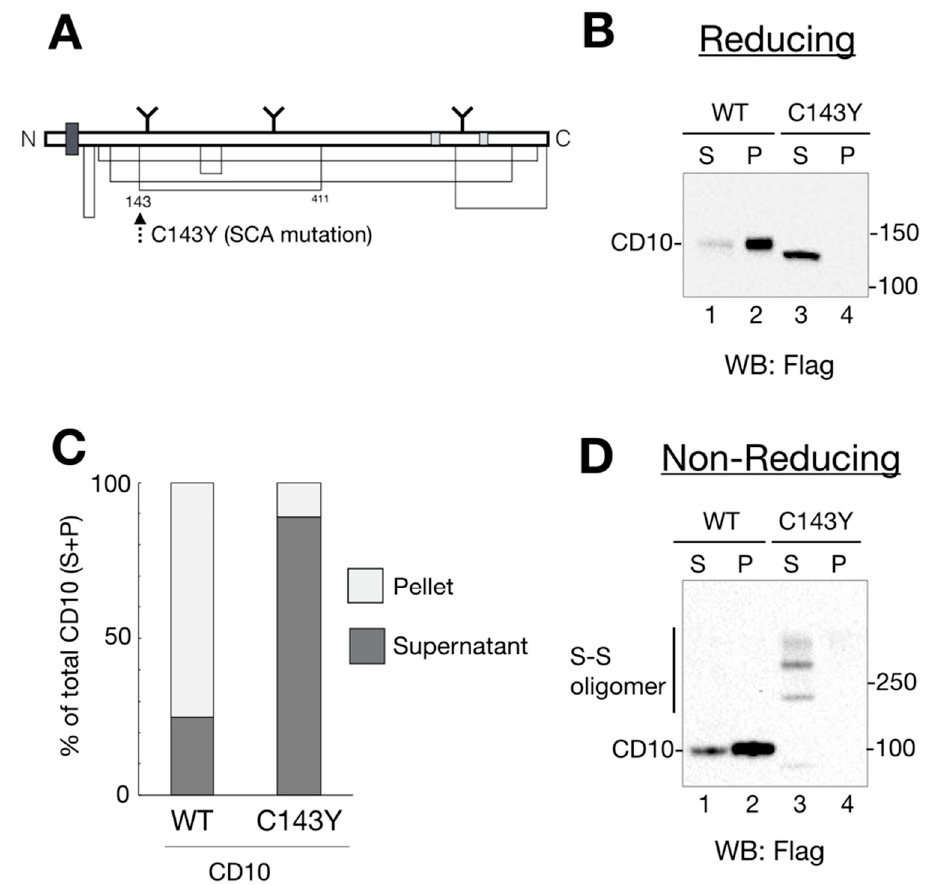
Figure 1. Spinocerebellar ataxia (SCA)-derived CD10 cysteine mutation causes aberrant disulfide bond formation and insufficient raft localization. ( A ), schematic representation of human CD10 structure. The thick dark gray square shows the transmembrane domain. N-linked glycans are noted as Y motifs with the glycosylation position. Enzyme catalytic sites are depicted in light gray. Disulfide bonds are shown as a solid line. Location of a SCA-related C143Y mutation is denoted by a dotted arrow. ( B ), wildtype (WT) CD10 is detected in a Triton X-100-insoluble fraction, whereas C143Y is solubilized. HeLa cells transfected with WT CD10 or C143Y-Flag vector were lysed and fractionated into detergent-soluble (S; soluble) and -insoluble (P; pellet) fractions. Proteins were resolved in reducing SDS-PAGE, followed by immunoblotting using anti-Flag antibody. Molecular weight of the marker proteins is shown on the right side of the gel. Lane numbers are shown on the lower side of the gel. ( C ), Quantification of B (ratio of S and P) is shown. The percentage of each band (WT, lanes 1 and 2; C143Y, lanes 3 and 4) is relative to the sum of all bands (100%). S and P are represented as dark gray and light gray, respectively. Results are shown as the ratio of proteins to the total protein (100%). Values are means of three independent experiments. ( D ), C143Y mutation induces disulfide bond-mediated oligomerization. Samples were prepared as mentioned in B, except for a denaturing process under the non-reducing condition. CD10 oligomers with disulfide bonds are denoted as “S–S oligomer” on the left side of the gel. Molecular weight of the marker proteins is shown on the right side of the gel.